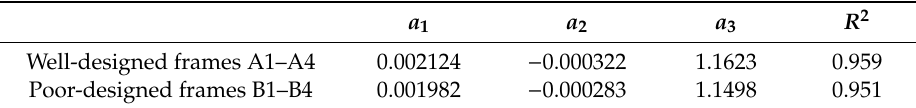
Table 2. Values of a 1 , a 2 and a 3 parameters.